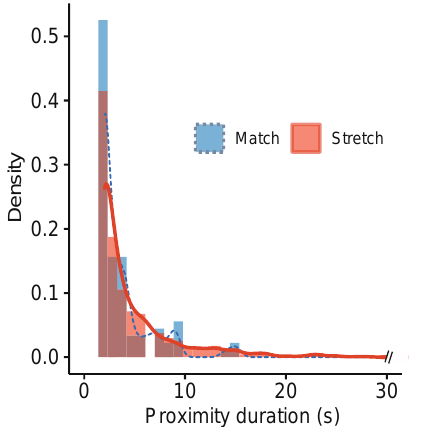
Figure 5. Density plot of the duration for each proximity ID during match time and stretching time.